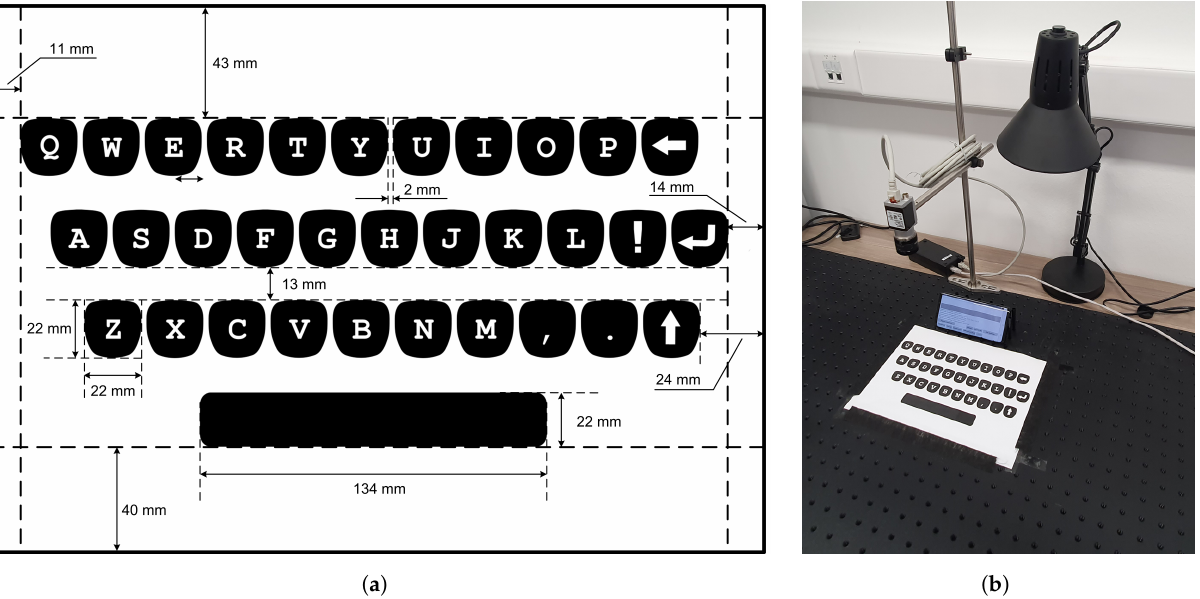
Figure 3. ( a ) Virtual keyboard layout used for text entry method enabled by magnet-based ADI. ( b ) Experiment setup for virtual keyboard magnet